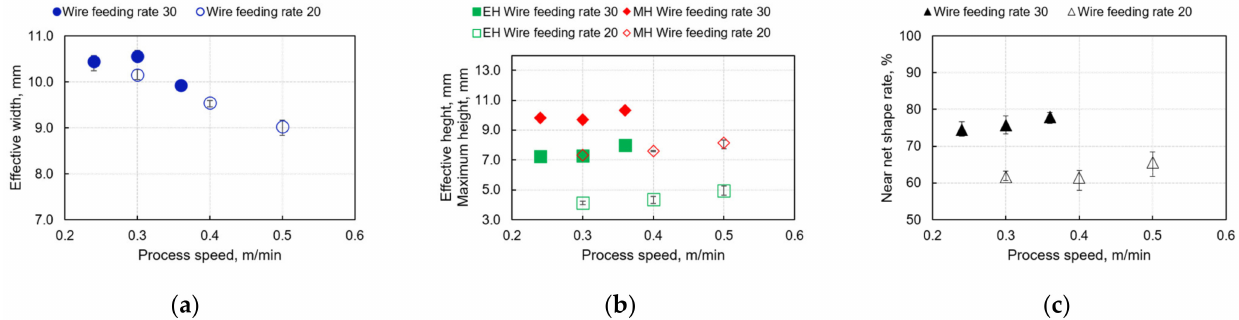
Figure 20. Cross-sectional characteristics ( P = 5.5 kW): ( a ) effective width, ( b ) effective height and maximum height, and ( c ) near net shape